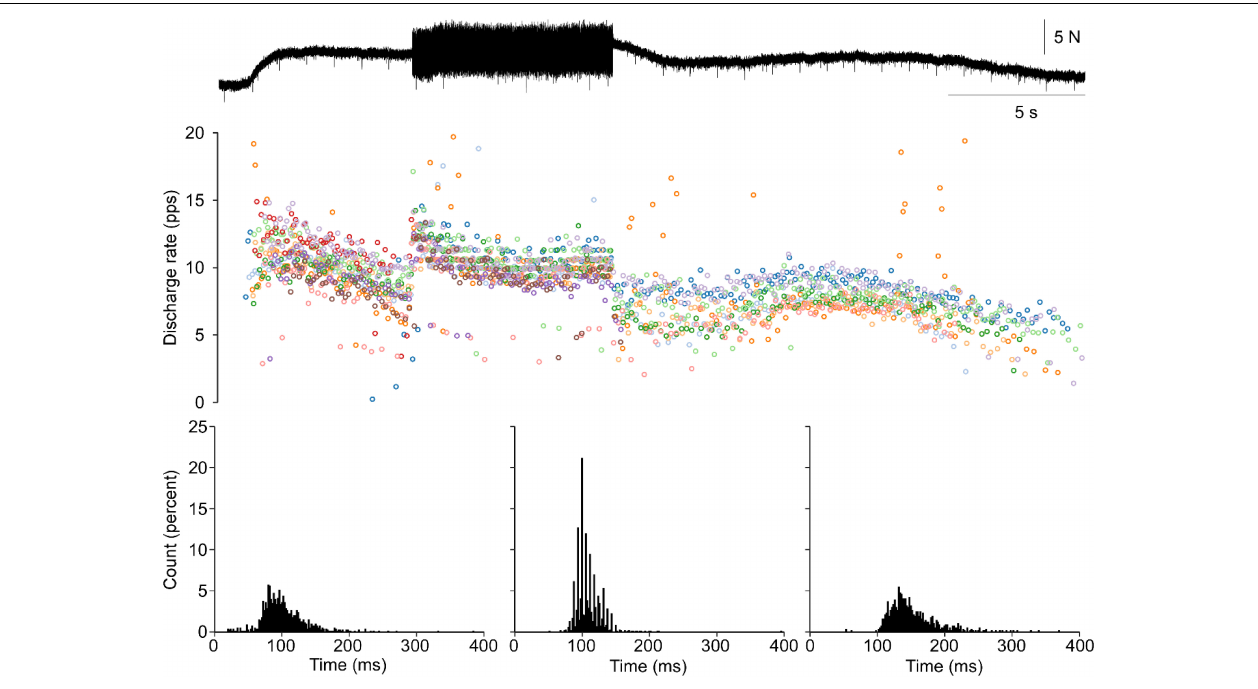
FIGURE 4 | Punctuated discharge remains with the addition of crossed extension. A single trial of relatively brief train of vibration is applied during a longer bout of crossed extension (XEX) stimulation. During XEX alone, no punctuation is observed. Concurrent vibration elicits an increase in both soleus torque and motor unit discharge rates. Furthermore, the discharge during TVR + XEX shows robust punctuation. This is observed in the representative data and the cISI histograms for the XEX alone (sides) and TVR + XEX